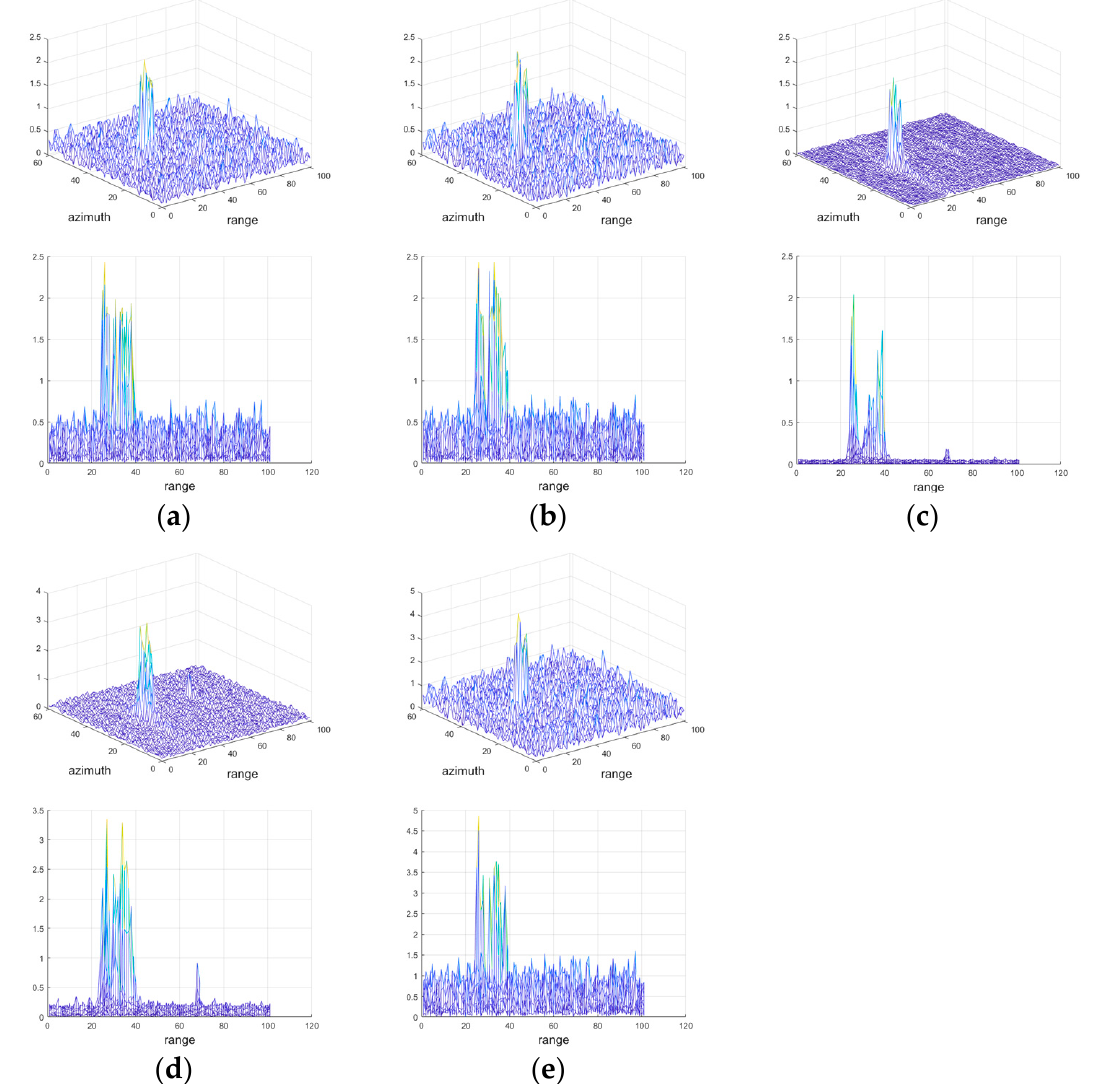
Figure 9. Three-dimensional figure of different channels. The first row of each figure is a 3D display of each channel. The second row of each figure is the 3D display of each channel in range direction view. ( a ) HH; ( b ) VV; ( c ) HV; ( d ) HH − VV; and ( e ) HH + VV.